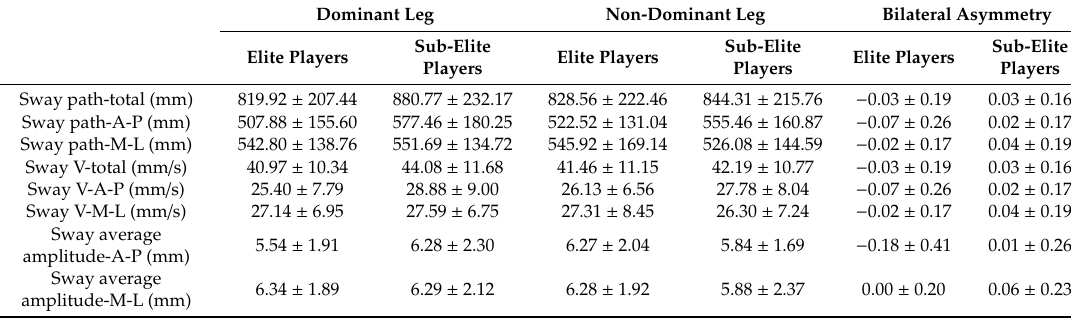
Table 1. Static unipedal balance test performance of both dominant and non-dominant leg in elite and sub-elite futsal players.